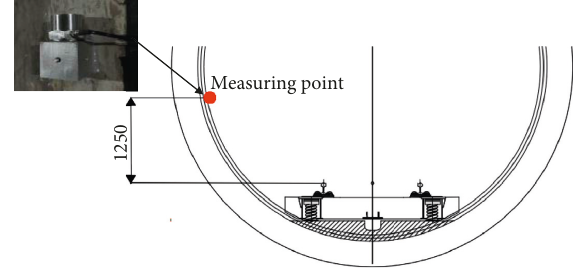
Figure 1: Measuring point location on the tunnel wall (unit: